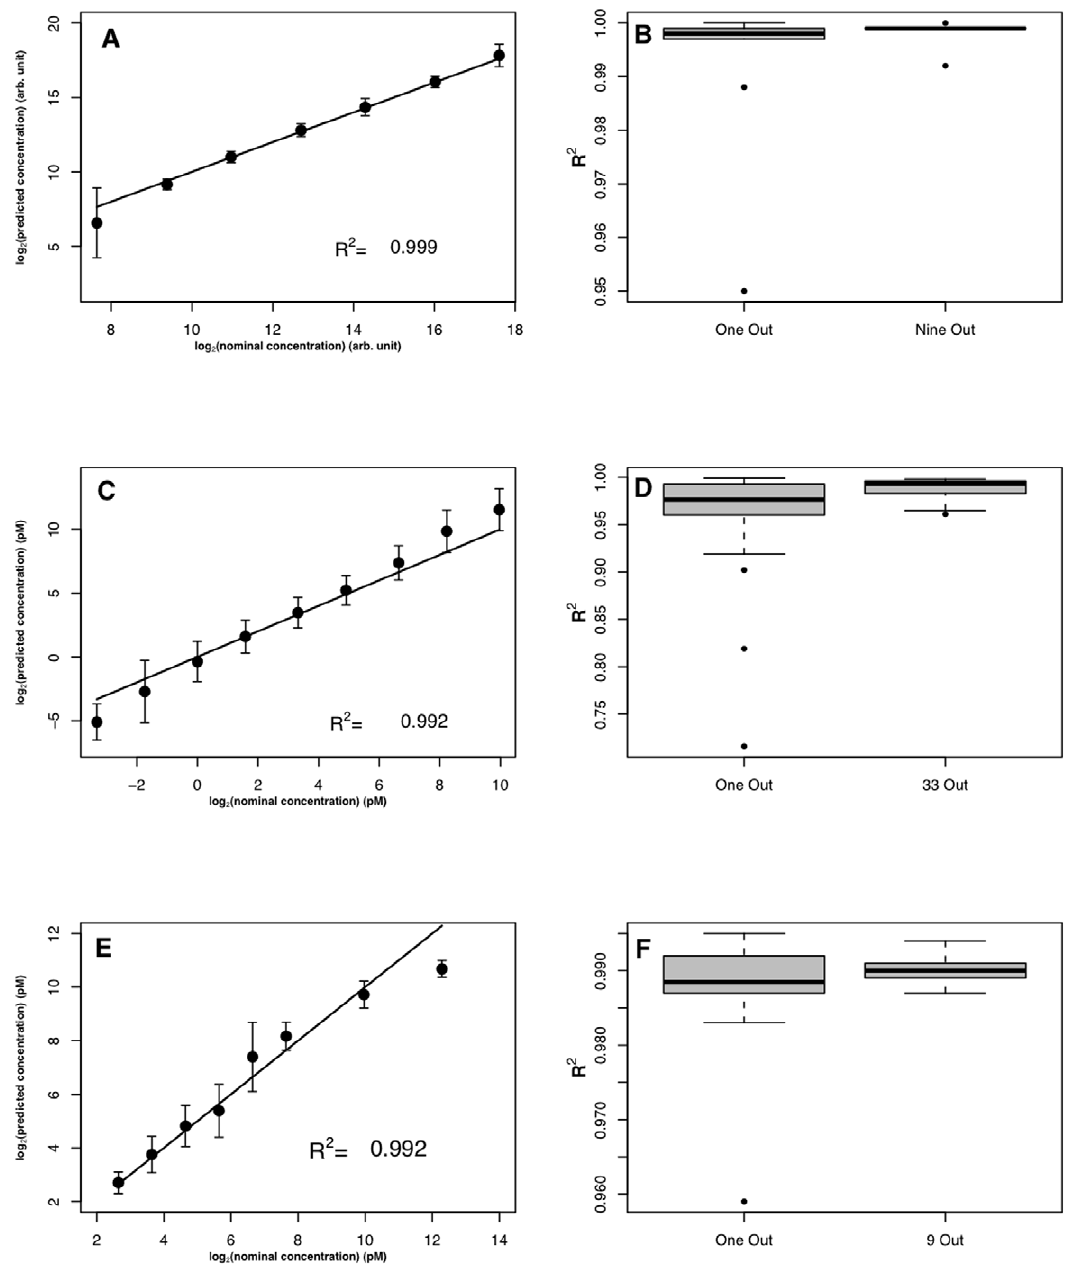
Figure 3. Estimation of transcript concentrations on the Agilent platform (A and B), Illumina platform (C and D) and pin-spotted platform (E and F). The first column shows results obtained from a comprehensive leave-one-out procedure. Error bars are the standard deviations of the ten transcripts. The solid line is the identity line ( x = y ). The second column shows box plots of R 2 for the ten (Agilent), thirty three (Illumina) and ten (pin-spotted) estimations of leave-one-out procedure and R 2 for five estimations of leave-nine-out (Agilent), leave-33-out (Illumina) and leave- nine-out (pin-spotted) procedures.